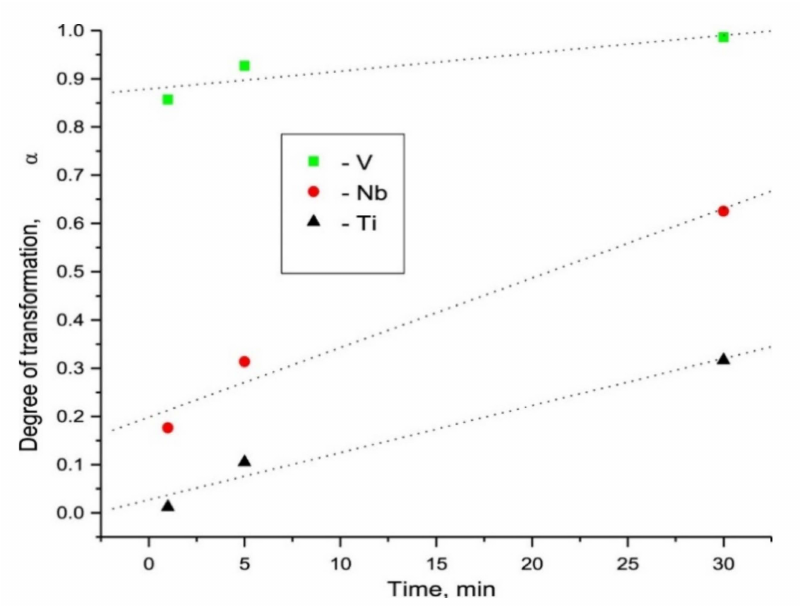
Figure 11. Dependences of the degree of transformation of Mg into its hydride on hydrogenation time during RT absorption with Ti, Nb or V additives [105]. (Reprinted with permission from